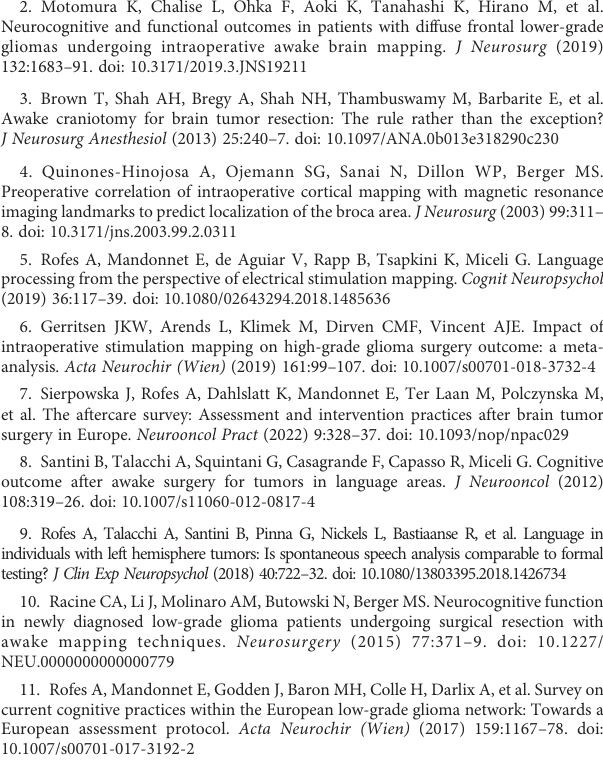
SUPPLEMENTARY FIGURE 1 The perioperative changes of KPS for patients with gliomas receiving awake brain mapping surgery at preoperative baseline (A) , discharging from hospitalization (B) and 3 months follow-up (C) evaluations. KPS, Karnofsky Performance Score.